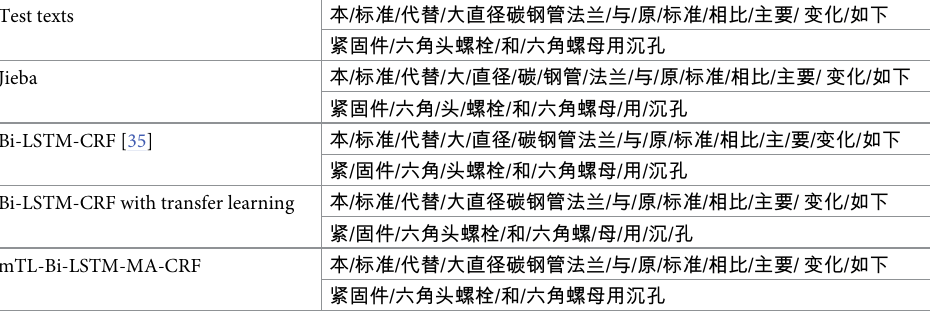
Table 3. Examples of CWS of